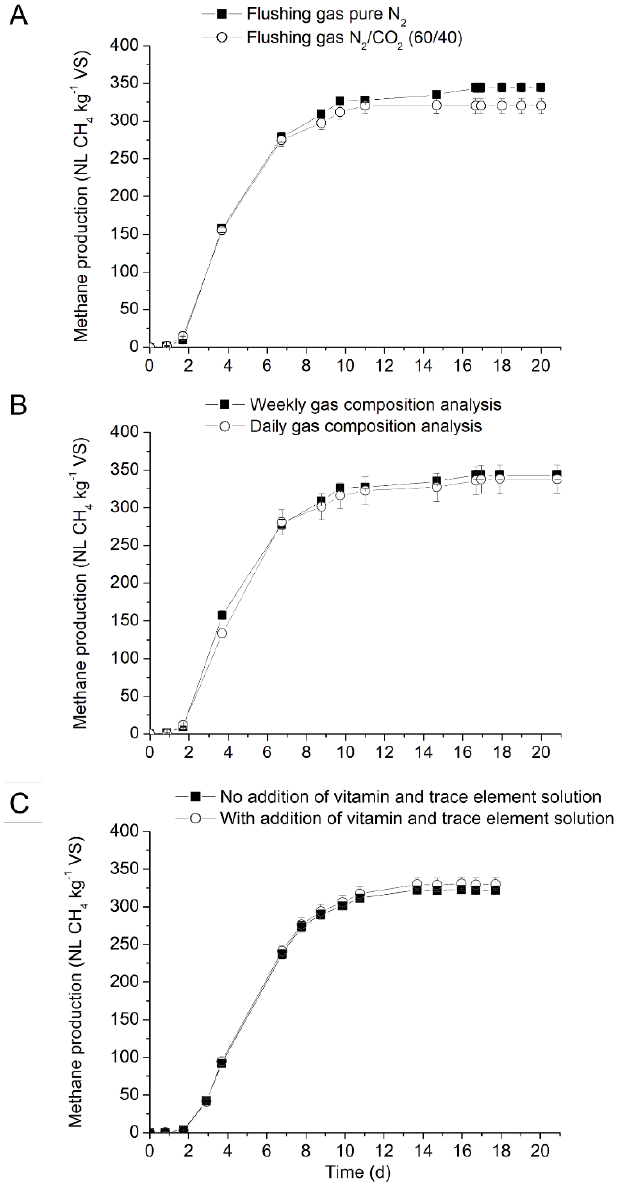
Figure 1. Influence operational factors on the mesophilic BMP of cellulose performed with Inoculum 1, ( A ) flushing gases, ( B ) analysis frequency, ( C ) vitamin and trace element